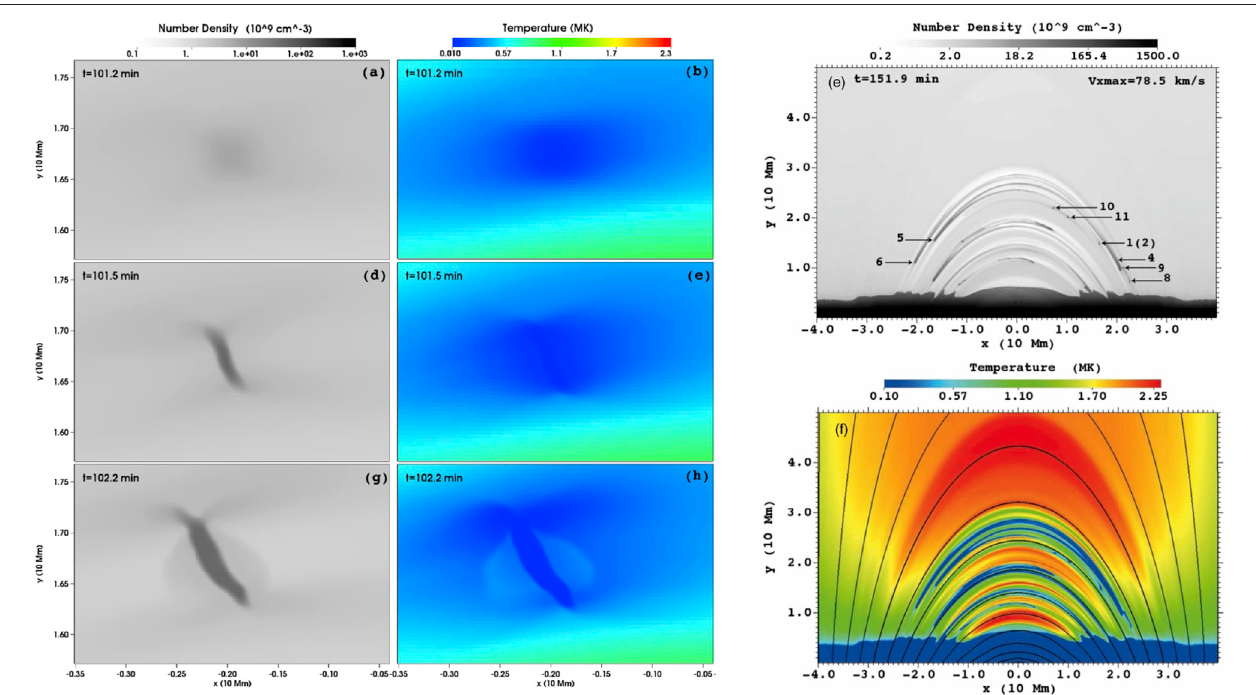
FIGURE 12 | 2.5D MHD modelling of coronal rain. Left: zoomed-in region of ≈ 3 × 2 Mm 2 focusing on the formation of a coronal rain clump within a loop arcade (shown on the right) as shown by Fang et al. (2015). Note that the clump fi rst forms in the direction transverse to the fi eld and grows over a distance of ≈ 1 Mm within 1 min.Thenumberdensity andtemperaturemaps areprovided.Right:theadvanced stageofthesame simulation,showninFangetal.(2013),whereseveralelongated (V-shape)clumpscanbeseen(topandbottompanelsshow,respectively,numberdensityandtemperature).AdaptedfromFigures1,2intherespectivepapers(© AAS. Reproduced with